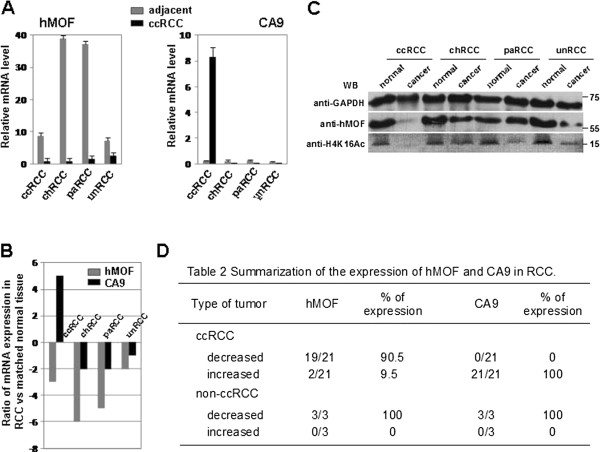
hMOF is downregulated in different pathological diagnosis of human kidney cancer. A. Relative mRNA expression levels of hMOF in different type of kidney cancer. Total RNA was isolated from four paired pathological diagnosed ccRCC, chRCC, paRCC, unclassified RCC, respectively and matched normal/adjacent kidney tissues. Relative mRNA expression levels of hMOF and CA9 were analyzed by qRT-PCR. Error bars represent the standard error of the mean of 3 independent experiments. B. Log2 ratio of hMOF and CA9 mRNA expression in four different types of human kidney cancer. Ratio of mRNA expression is displayed as a ratio of expression of hMOF or CA9 gene in ccRCC versus matched normal tissues. C. Analysis of werstern blotting. Equivalent total protein amount of whole cell extracts from four different pathological diagnosed kidney cancers (ccRCC, chRCC, paRCC and unRCC) and its corresponding normal/adjacent tissues were subjected to SDS-PAGE in 12% gels, and proteins were detected by western blotting with indicated antibodies. D. Summarization of hMOF and CA9 expression in RCC. Total cases of ccRCC (21) include four initial selected ccRCC (data not shown), sixteen additional ccRCC and one case used in comparing experiment.